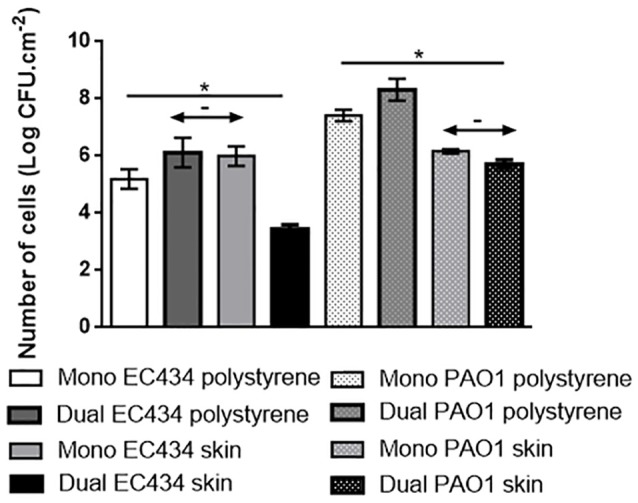
Bacterial colonization (CFU.cm−2) of 24 h-old biofilms of E. coli 434 and P. aeruginosa PAO1 formed individually (Mono) or combined (Dual). Number of cells in dual species biofilms were counted separately on MacConkey for E. coli or PIA for P. aeruginosa. Data are shown as mean ± SD and results. With the exception of the two arrowheads with “-” all other values were considered statistically different (*p ≤ 0.05).